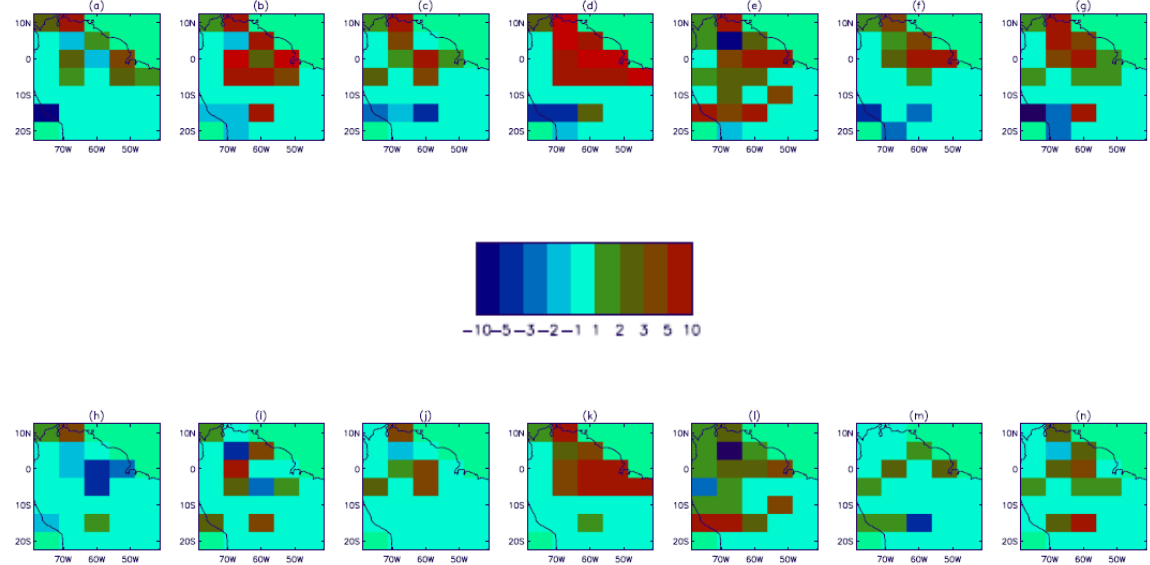
Fig. 6. Difference between the combined-PFT LAI of the mid-Holocene and α 7 runs (a–g) and the equivalent residual plots for the LGM and α 7 runs (h–n)